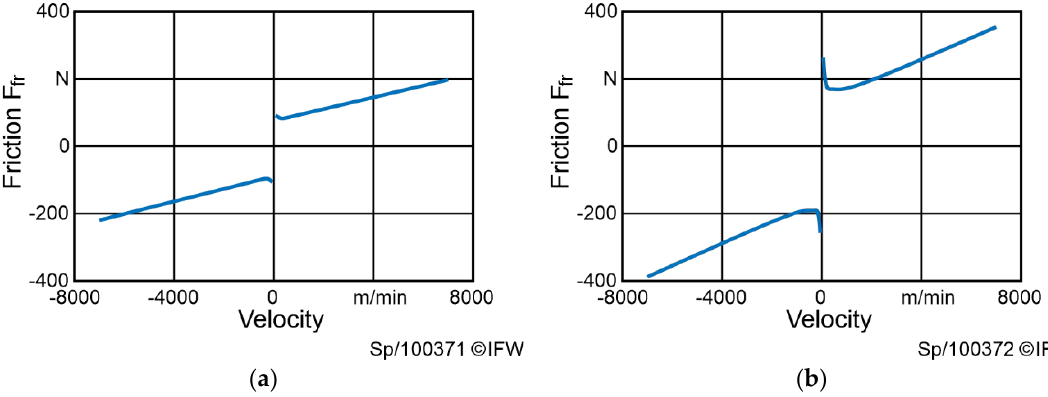
Figure 2. Stribeck curve: ( a ) fitted for the X -axis of the HSC30; ( b ) fitted for the Y -axis of the HSC30. Third, the friction is reconstructed by a Stribeck curve, described by Equation (4) [18].